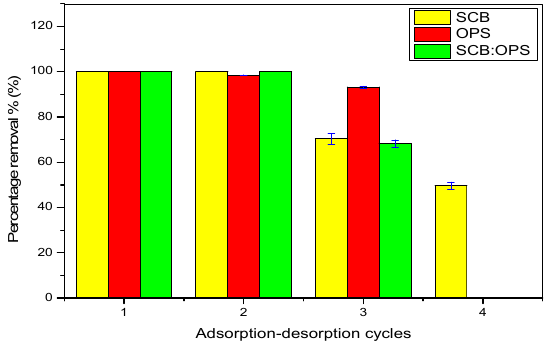
Figure 16. Pb(II) adsorption–desorption cycles.